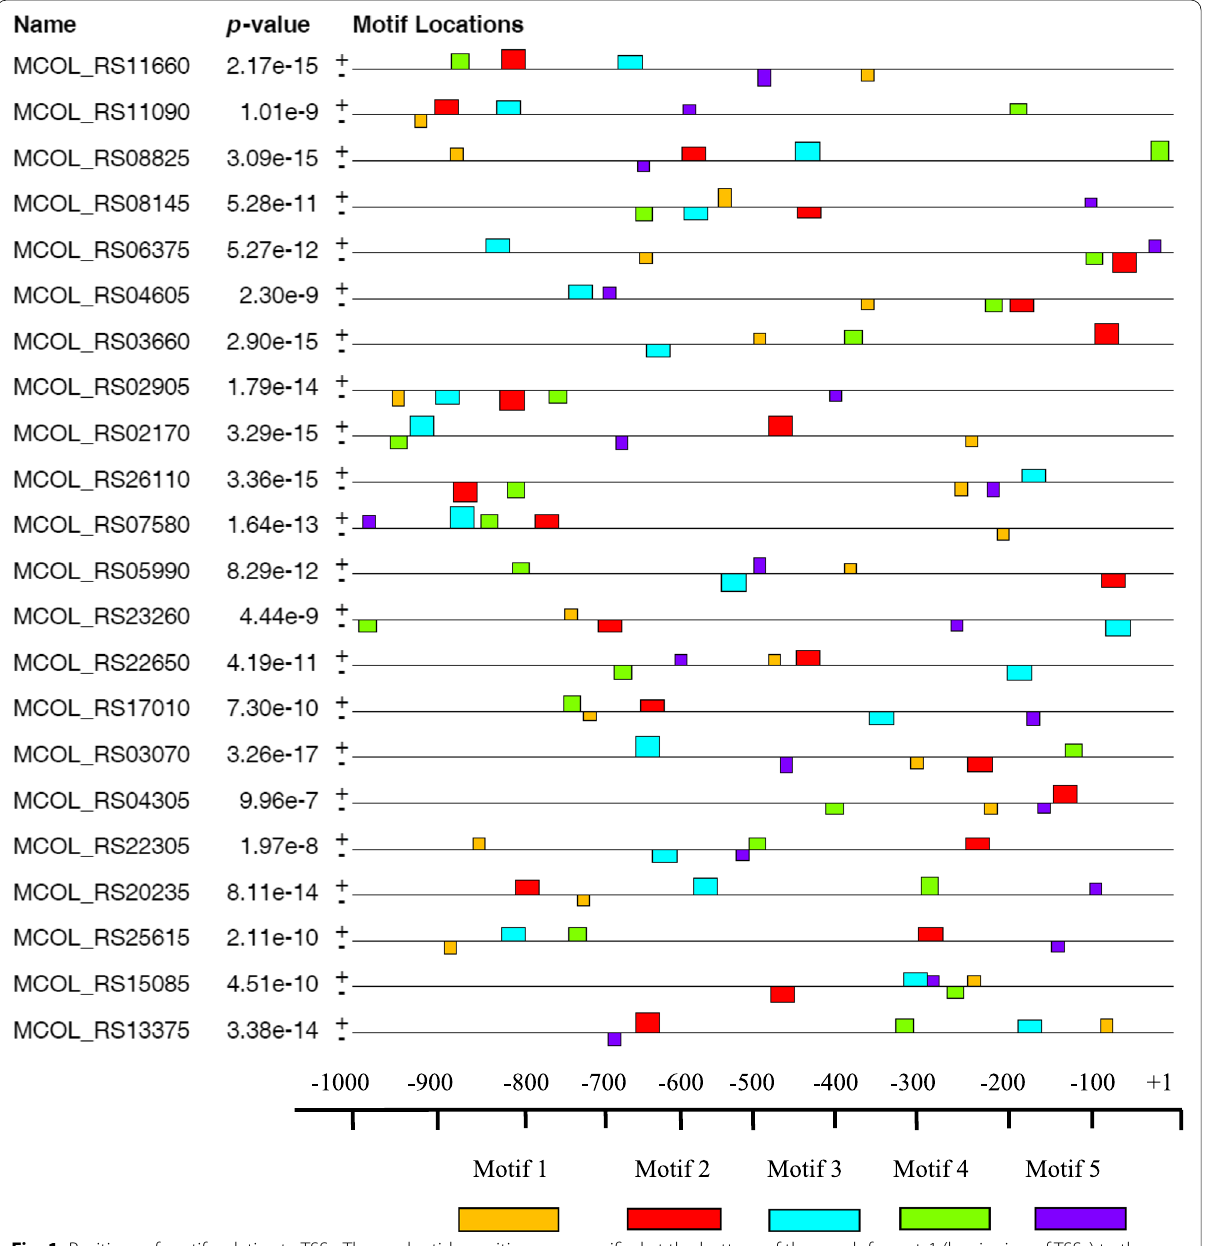
Fig. 1 Positions of motifs relative to TSSs. The nucleotide positions are specified at the bottom of the graph from upstream 1 kb (